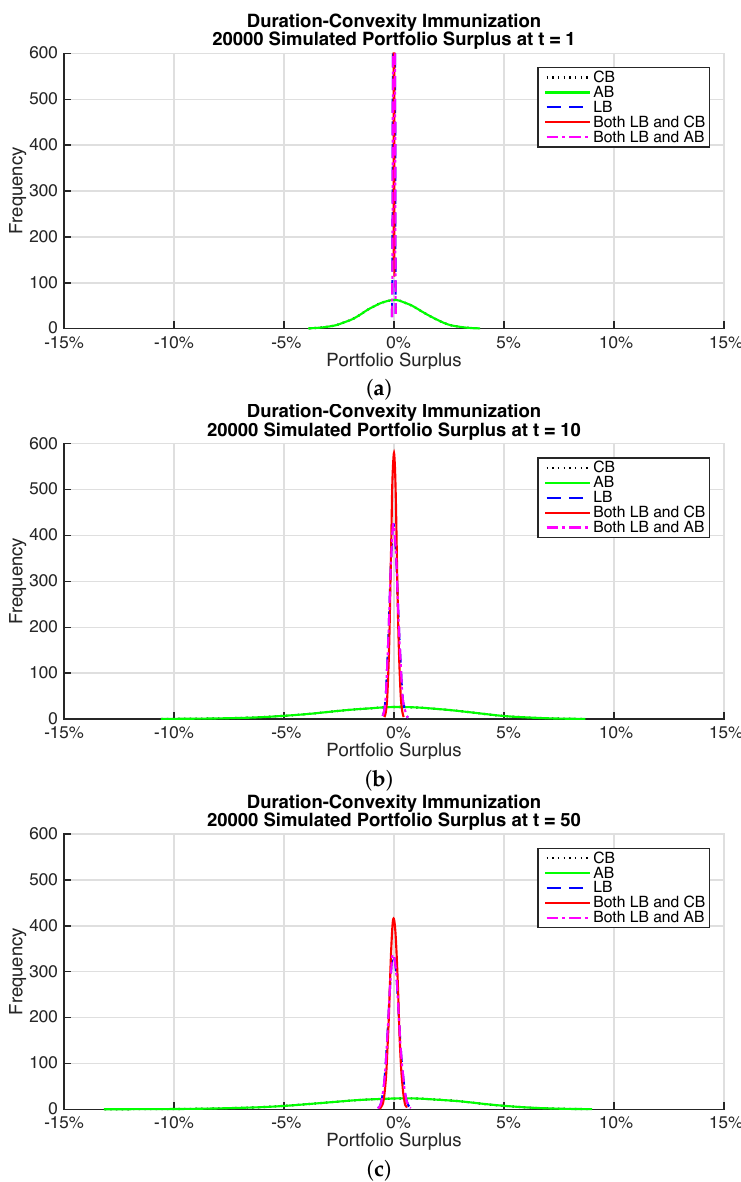
Figure 6. Surplus Distribution—Immunization. ( a ) Time horizon—1 year; ( b ) Time horizon—10 years; ( c ) Time horizon—50